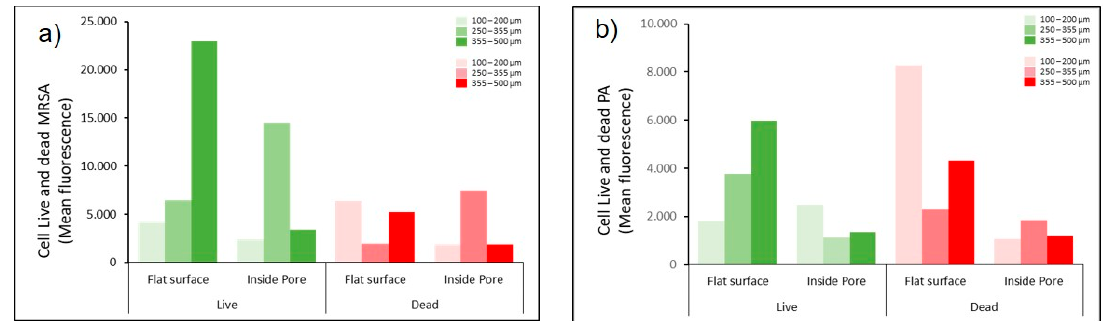
Figure 10. Quantification of fluorescence intensity of confocal images for the three different substrates for both cell lines MRSA ( a ) and PA ( b ). Results are expressed as the mean of the fluorescence intensity signal measured using Image J software.